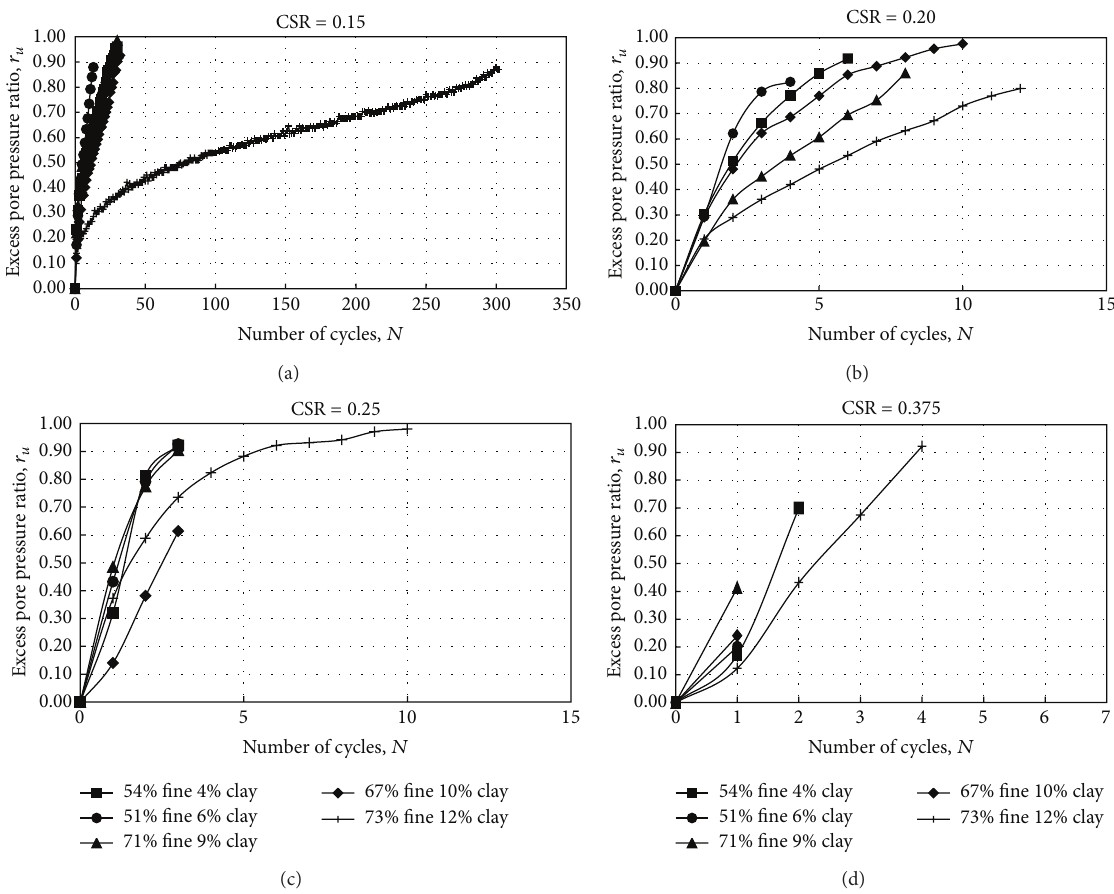
Figure 6: The pore pressure-number of cycles and axial strain-number of cycles relationship for a different